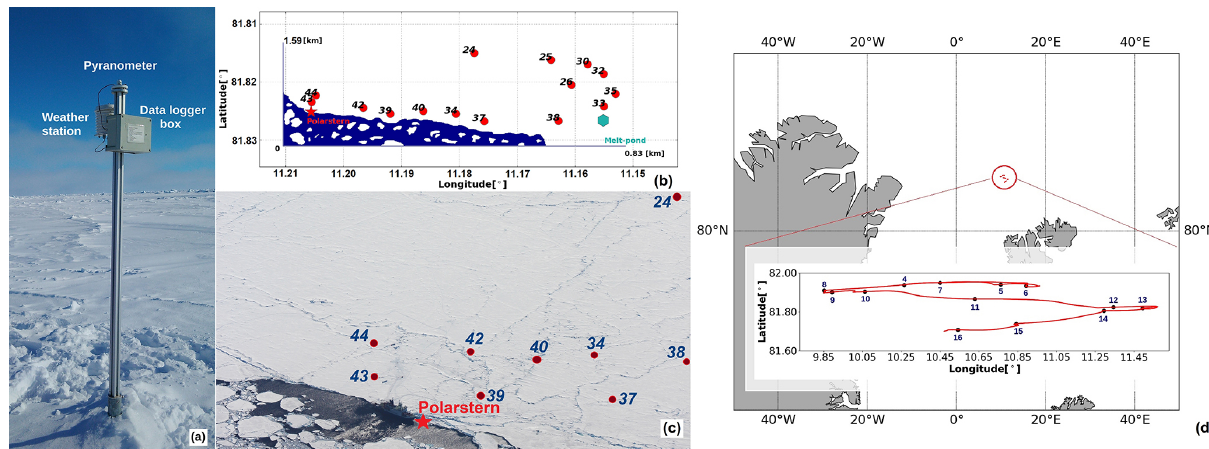
Figure 1. (a) Photograph of a pyranometer station on the ice floe. (b) Map of the pyranometer stations. Red circles show the location on 11 June 2017, at 14:50Z, while the red star marks the position of Polarstern and the turquoise hexagon marks the approximate position of a melt pond. Note that the latitude and longitude axes have been inverted for easier comparison with panel (c) . (c) Edited photograph of the ice floe station showing the approximate location of several stations (red circles) and Polarstern (red star). Photographed by Svenja Kohnemann. (d) Drifting track of the ice floe from 4 to 16 June.